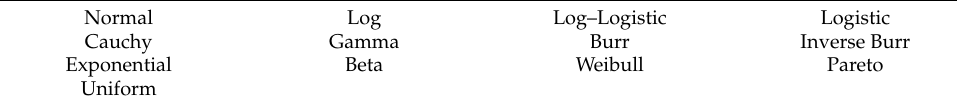
Table 4. Parametric